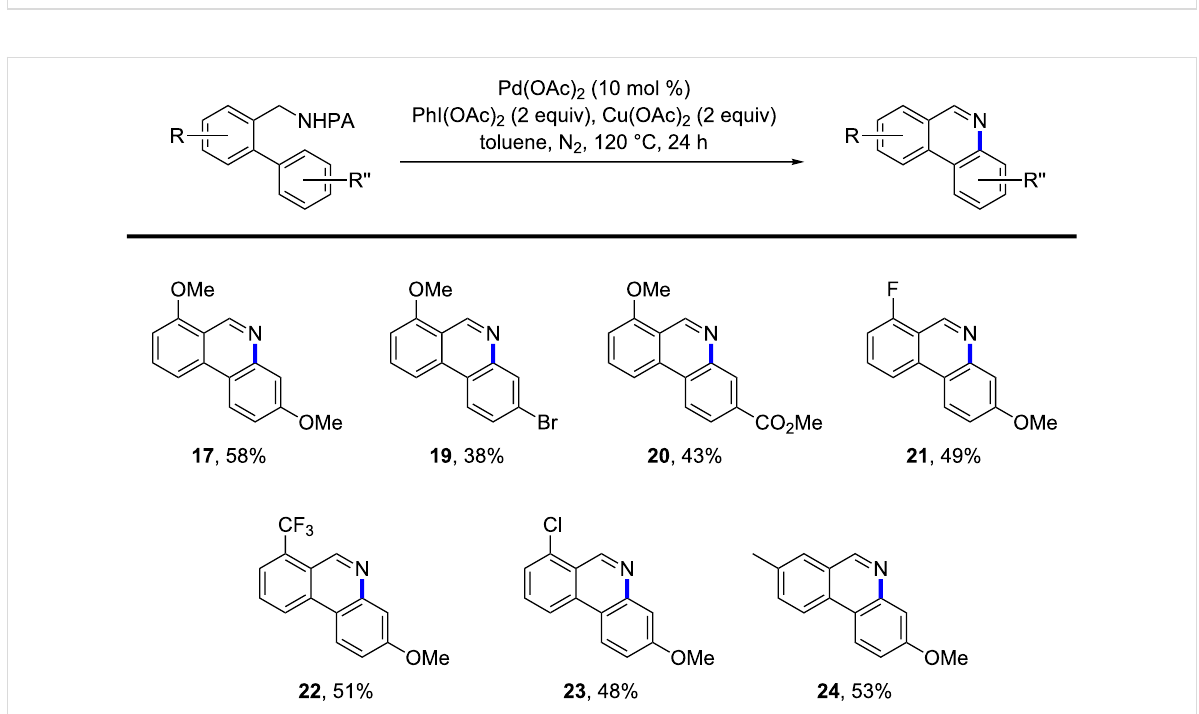
Figure 2: Substrate scope of this phenanthridine synthesis. All reactions were carried out in a 10 mL glass vial on a 0.2 mmol scale; yields are based on isolated product.